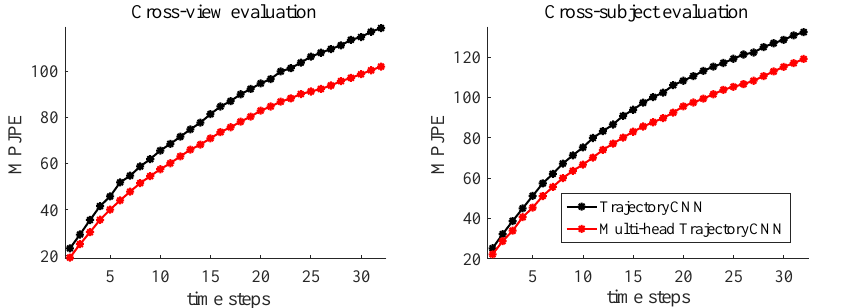
Figure 5. Frame-wise performance of human motion prediction. “MPJPE” denotes the mean per-joint position error of future poses by Equation (5), and “time steps” denotes the frames of future poses.